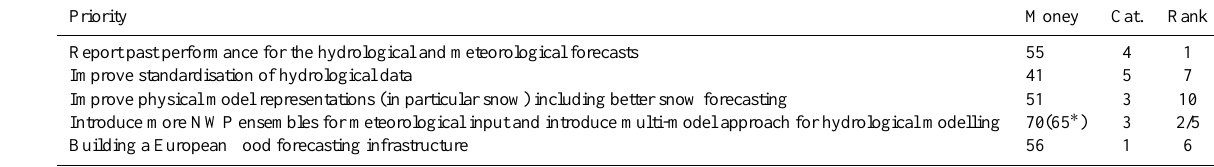
Table 3. Result after the voting with 10SEK after the pitch before the expert panel. 268 of originally 300krona was recovered, meaning a total of 32krona was kept by the participants. The column “Cat” denotes which category each priority belongs to, and “Rank” which rank the priority was given in the questionnaire.